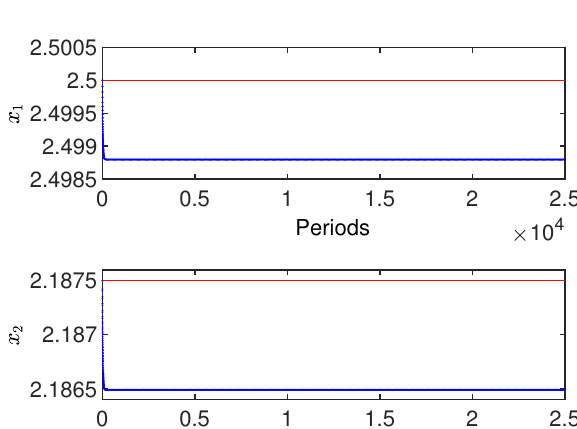
Figure 6. State space.